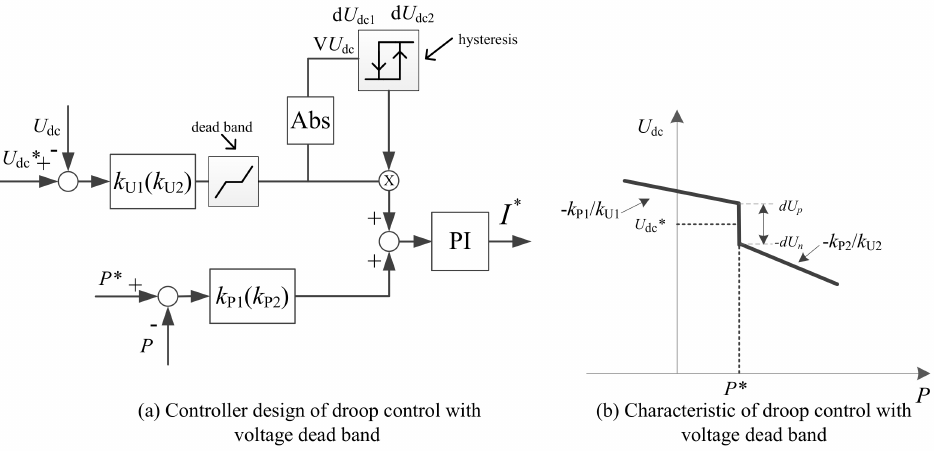
Figure 7. Droop controller design with the additional voltage dead